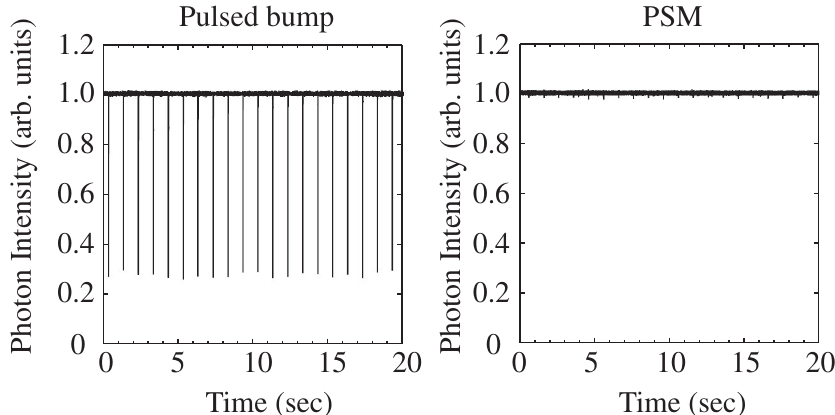
FIG. 21. Stability of photon intensity at BL-14A in the pulsed bump injection (left graph) and the PSM injection (right graph). The spike train appeared at exactly 1 Hz in both graphs, synchronized with the beam injection. The sampling rate of the signals was 10 kHz.